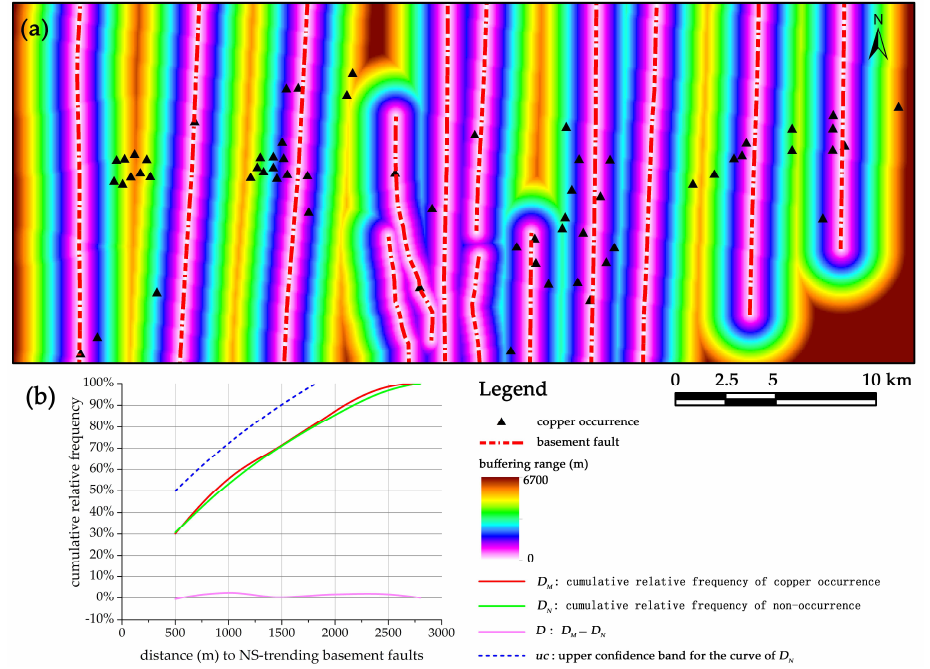
Figure 8. ( a ) Buffer analysis and ( b ) graph of cumulative relative frequency concerning distance to intersections of basement faults.